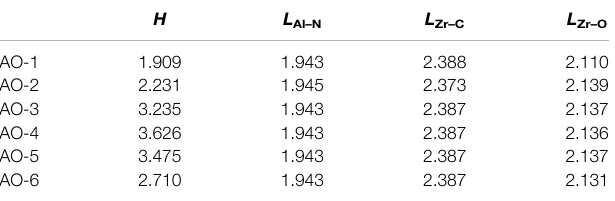
TABLE 1 | The optimized distance of interface ( H , Å) and the bond length ( L , Å) of the AlN/Zr 2 CO 2 heterostructure with different stacking styles.